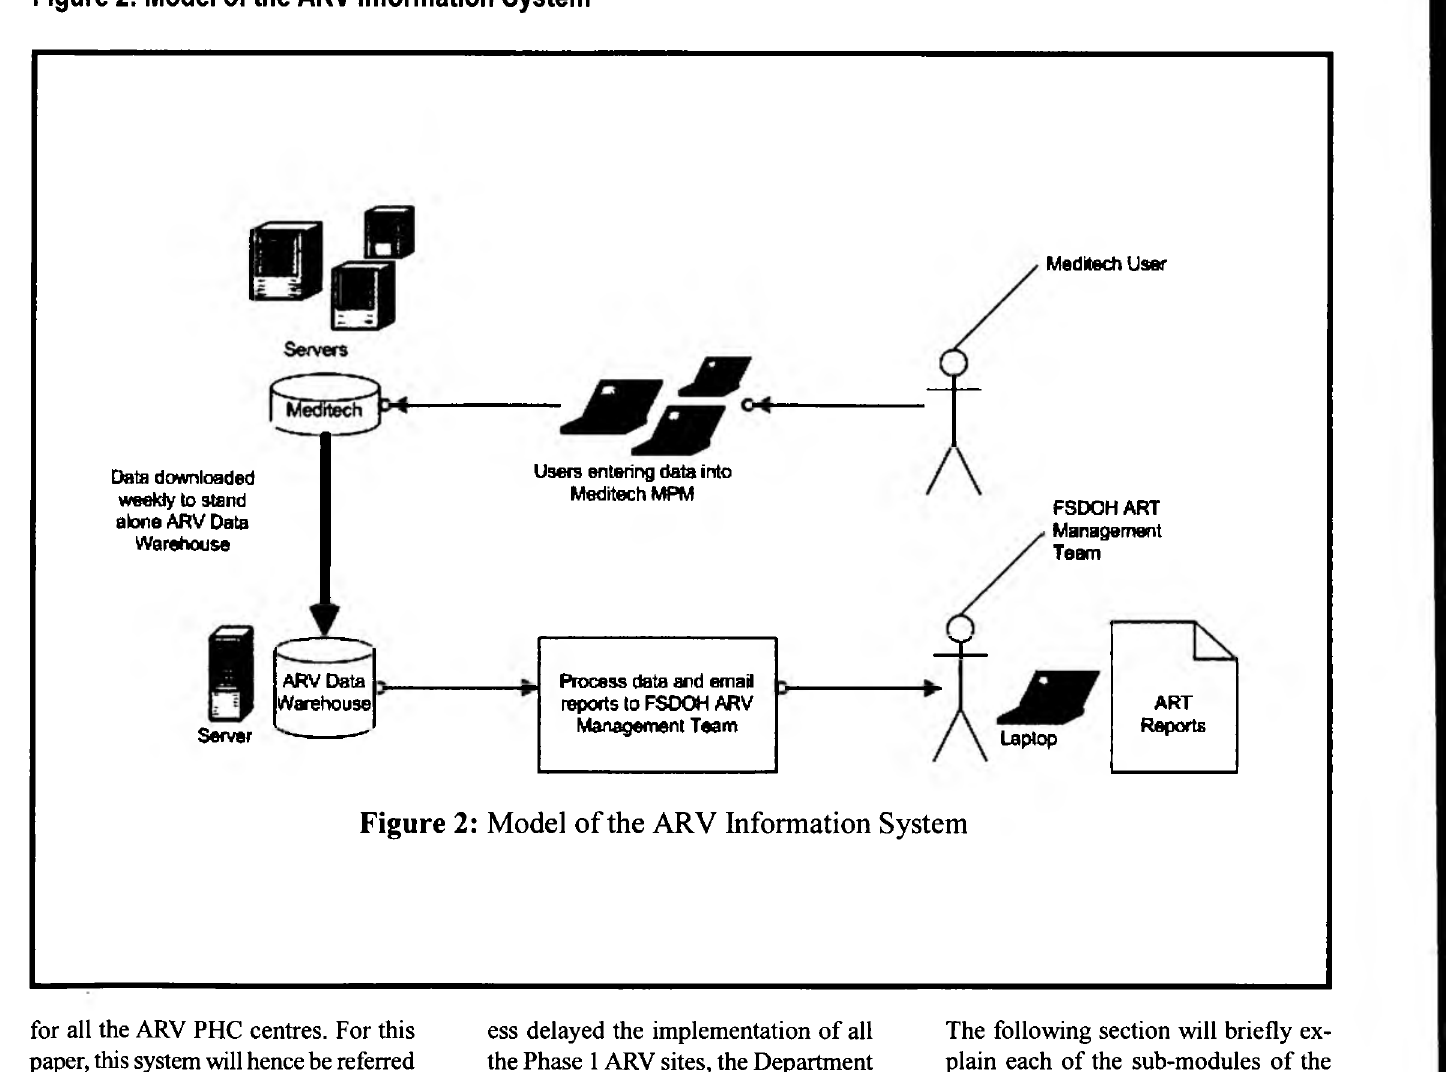
Figure 2: Model of the ARV Information System